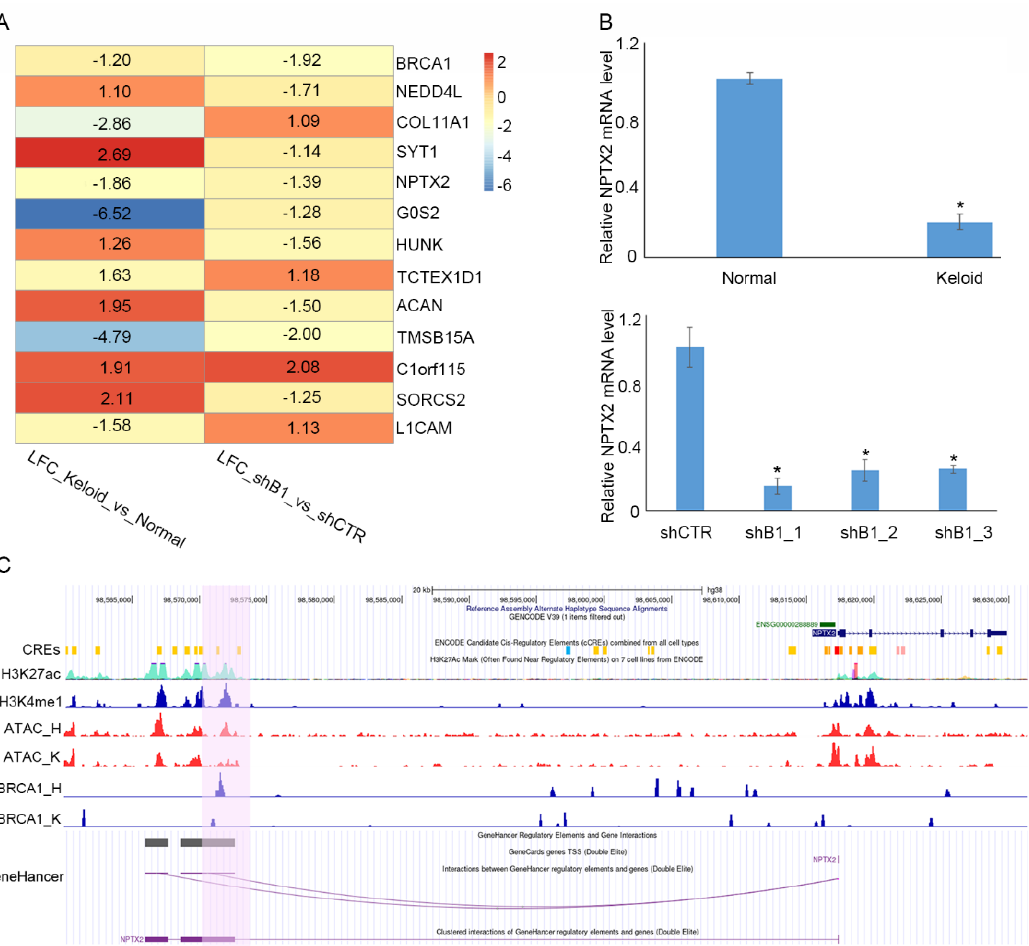
Figure 5. BRCA1 might regulate NPTX2 expression by manipulating its enhancer accessibility and influencing enhancer–promoter interactions in normal DF. ( A ) Heatmap of the log2-based fold change of genes that significantly affected differential expression in both shB1 normal DF compared with shSCR normal DF and keloid DF compared with normal DF. LFC, log2-based fold change. ( B ) Validation of down-regulation of NPTX2 in keloid DF relative to normal DF (upper panel) and shB1 normal DF relative to shSCR normal DF (bottom panel). ( C ) Density profile of H3K27ac and H3K4me1 CUT&Tag-seq in keloid DF, ATAC-seq in normal and keloid DF, BRCA1 CUT&Tag-seq in normal and keloid DF at NPTX2 as well as its associated enhancer region. Interaction between NPTX2 enhancer and promoter predicted based on GeneHancer database is shown in bottom. H, normal DF; K, keloid DF. The promoter-associated enhancer that exhibits looser chromatin organization and higher BRCA1 binding signal is highlighted by purple background. ShB1, shBRCA1.